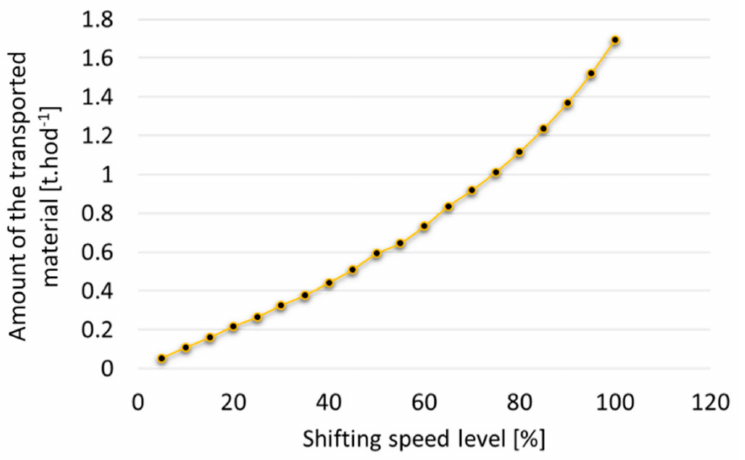
Figure 13. Dependence of the average value for amount of the transported material, STEEL GRIT GH50, on the adjusted shifting speed level.